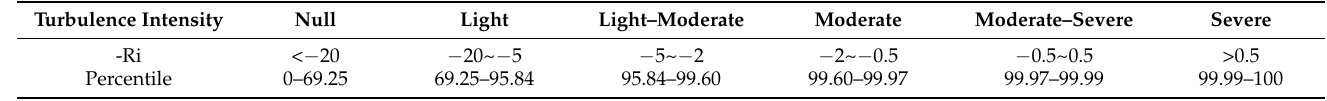
Table 1. The range of turbulence intensity percentiles according to the Richardson